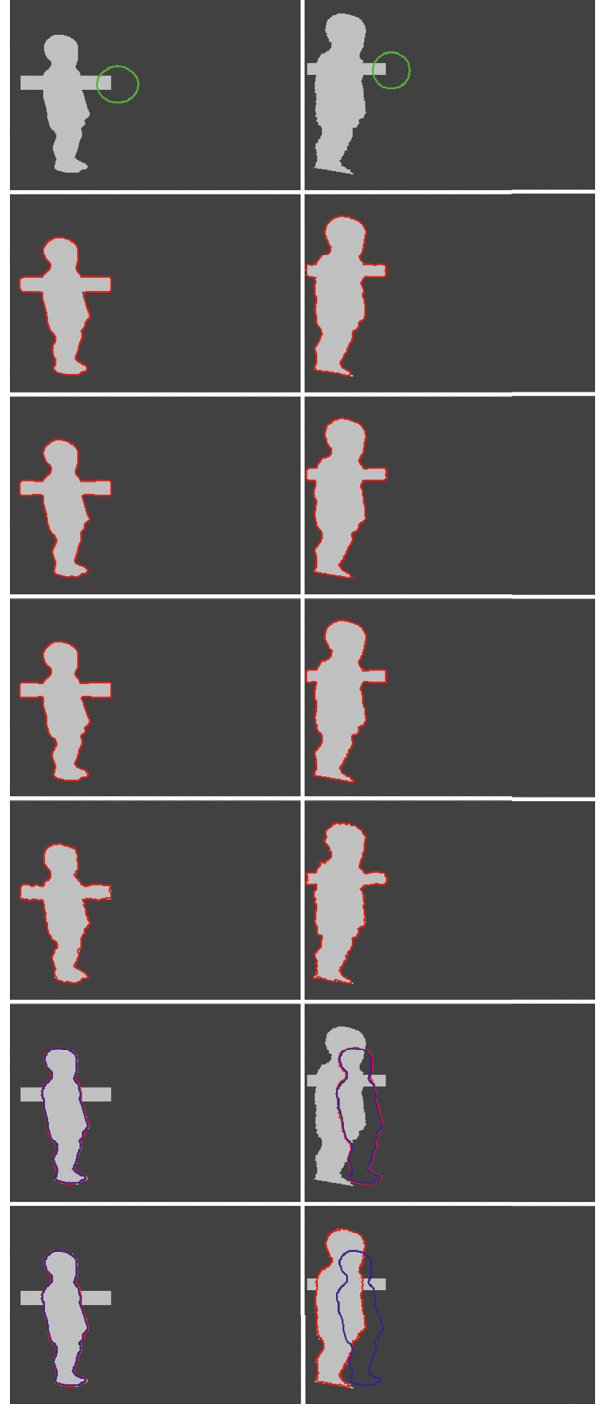
Figure 2: A set of comparison segmentation experiments on synthetic images with a single prior. The first row is the input images along with artificial interference and initial contours. The second to seventh rows are the segmentation results by using the LSEWR, RSF, LGDF, LIF, CREMERS, and our SP-LEM models, respectively. The green, red, and blue contours are the initial contour, the final target contour, and the input shape prior, re- spectively. The relevant task parameters are N � 1, μ � 0 . 04, Δ t � 5 . 5, σ � 3, and ε �